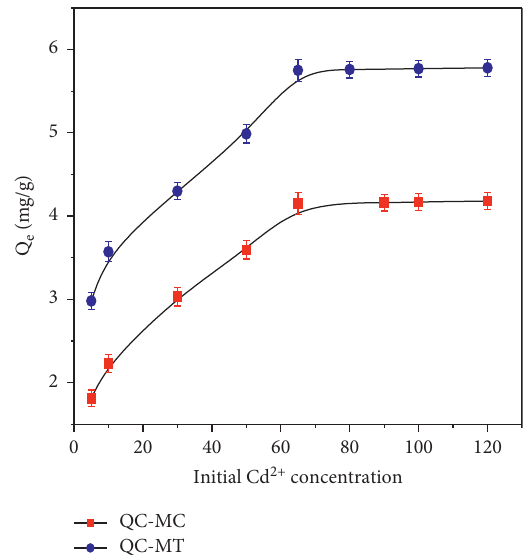
Figure 6: Effect of initial concentration of Cd (II) ions for QC-MC and QC-MT ( V � 100 mL, T � 25 ° C, m � 1.5g, contact time- � 45min for QC-MC and 30min for QC-MT, and pH �